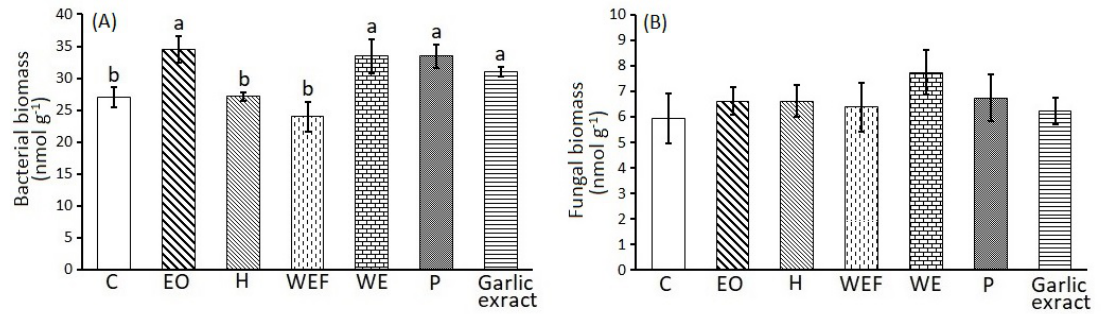
Figure 2. Mean values (± st. error) of soil bacterial and fungal biomass of the experimental plots (C: water control; EO: essential oil; H: hydrosol; WEF: water extract filtered; WE: water extract; P: powder and garlic extract), 45 days after treatment. Different letters above columns correspond to statistically significant differences between treatments, as revealed by one-way ANOVA (Tukey p < 0.05).